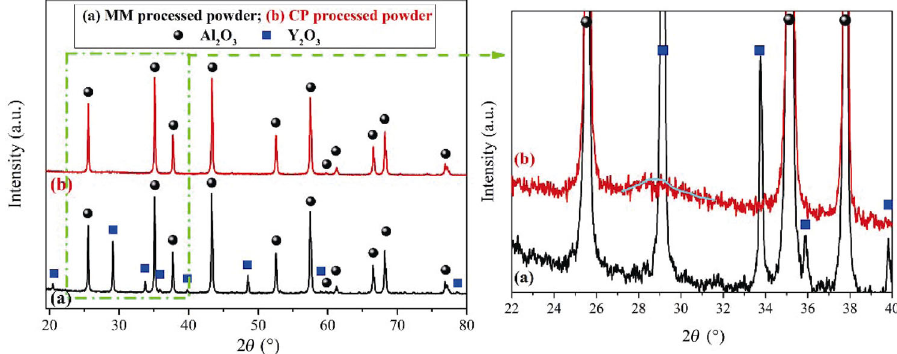
Fig. 3 XRD patterns for the MM and CP processed Y 2 O 3 –Al 2 O 3 composite powders. The right image is the local enlargement of left image marked by green